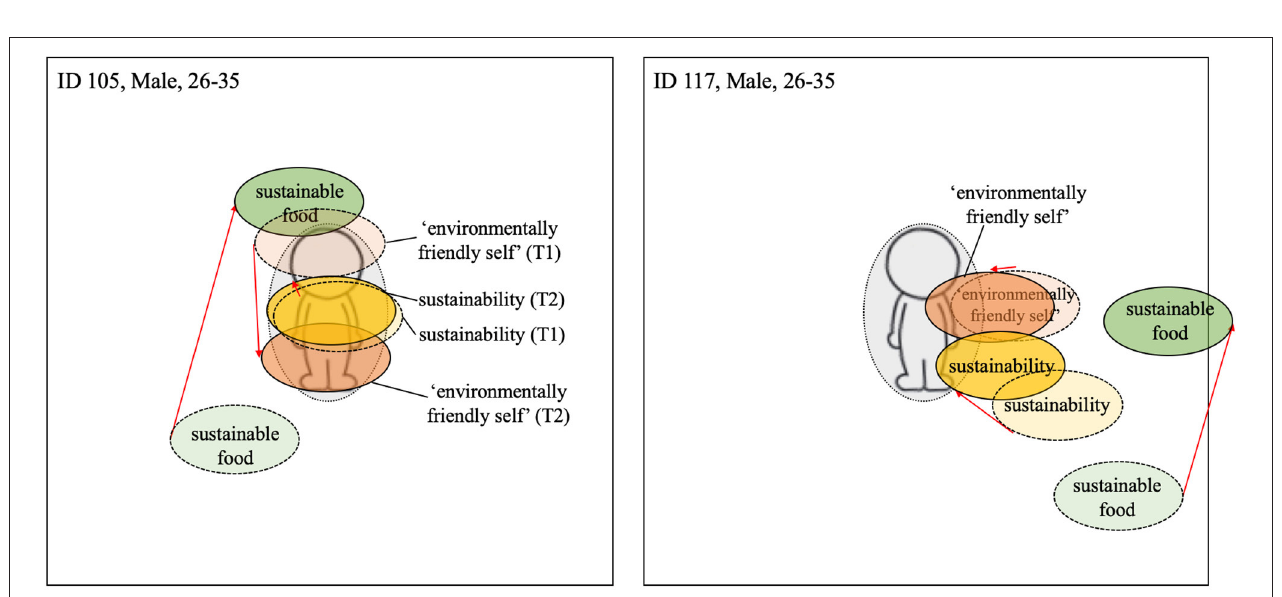
FIGURE 4 | Visualization centrality of identity—Local food; Dashed line = T1; solid line and darker coloring = T2; Red arrow indicates change from T1 to T2 (the colors were added after the analysis).